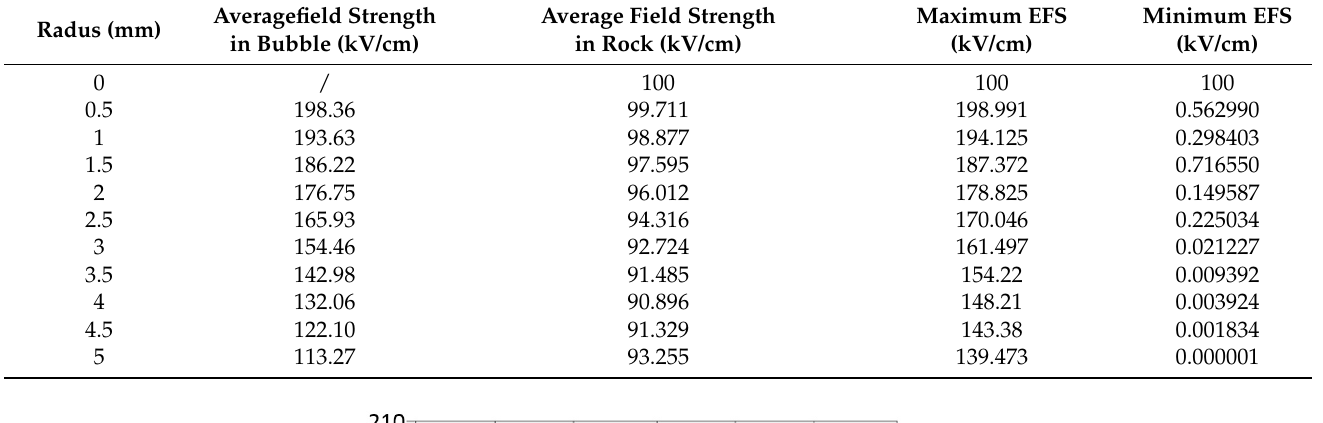
8 of 17 Figure 9. EFS distribution of rock under the influence of 3 mm—radius bubble. (3) By changing the radius of the middle bubble to adjust the area of the bubble, the in- fluence of the bubble size on the EFS of rock is analyzed, as shown in Table 1. The